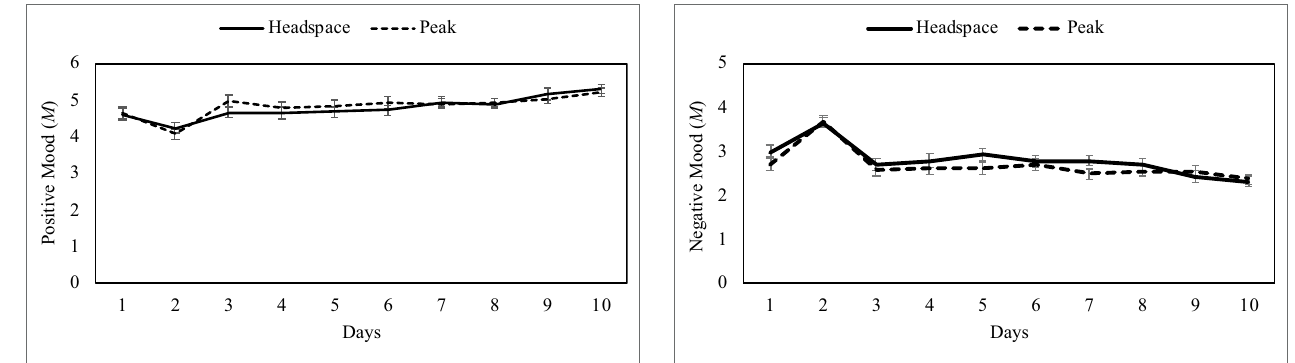
FIGURE 3 | Mean positive mood scores by intervention day and condition, with ±1 standard error bars.